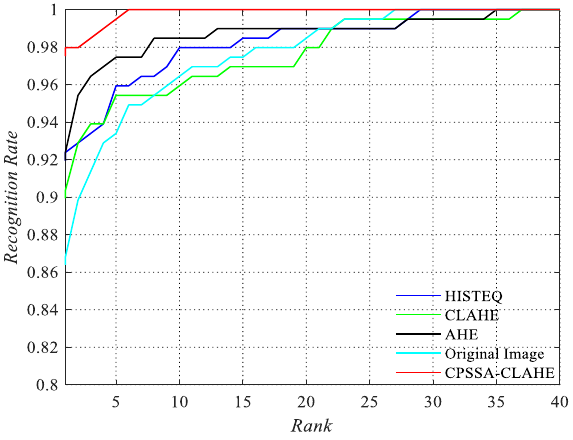
Figure 10. Recognition rate of different image enhancement